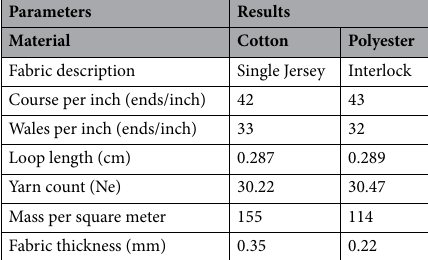
Table 1. Knitted fabric